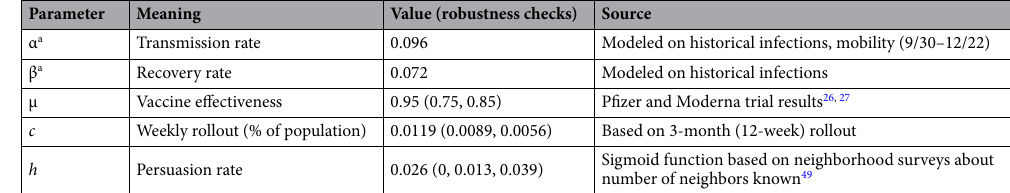
Table 2. Fixed values and sources for parameters in the baseline simulation model and robustness checks. a The more familiar R 0 = α/β =